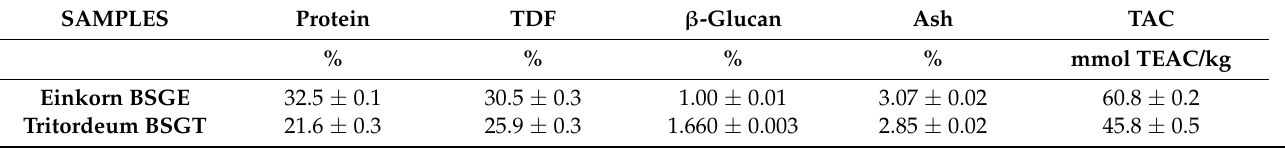
Table 1. Basic composition of brewer spent grain (BSG) from einkorn and tritordeum. SAMPLES